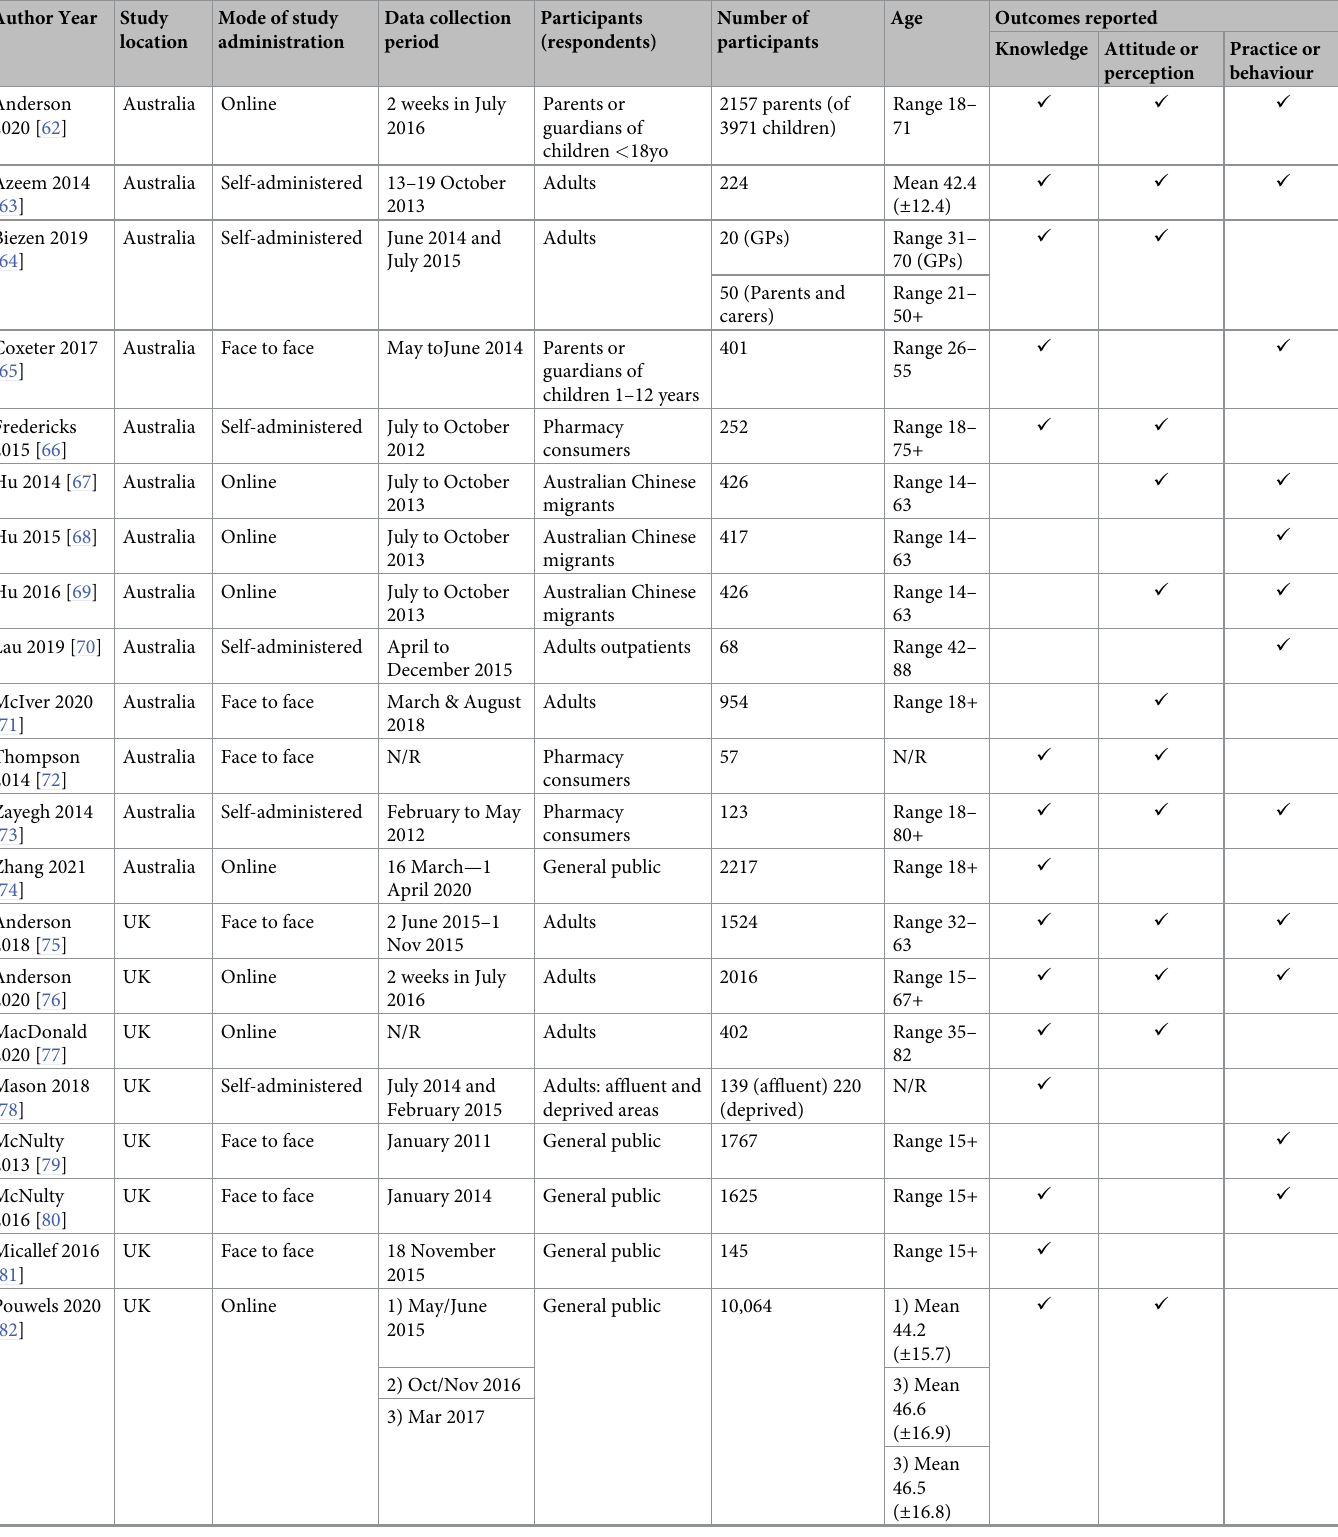
Table 1. Characteristics of included